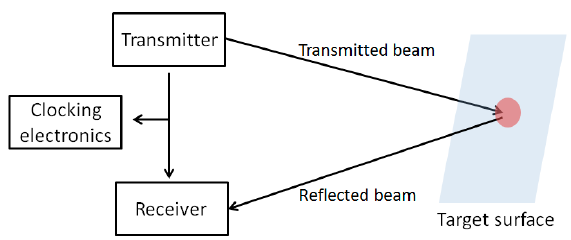
Figure 11. Reflective laser scanning system.